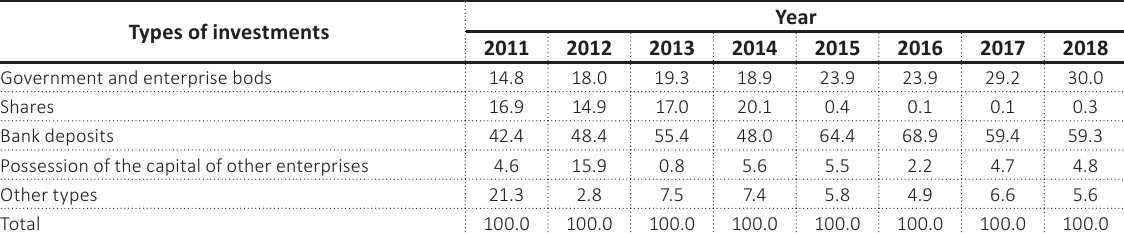
Table 3. Structure of financial income of Ukrainian IC, received from investment allocation in 2011–2018, % Source: Calculated by National Commission for State Regulation of Financial Services Markets